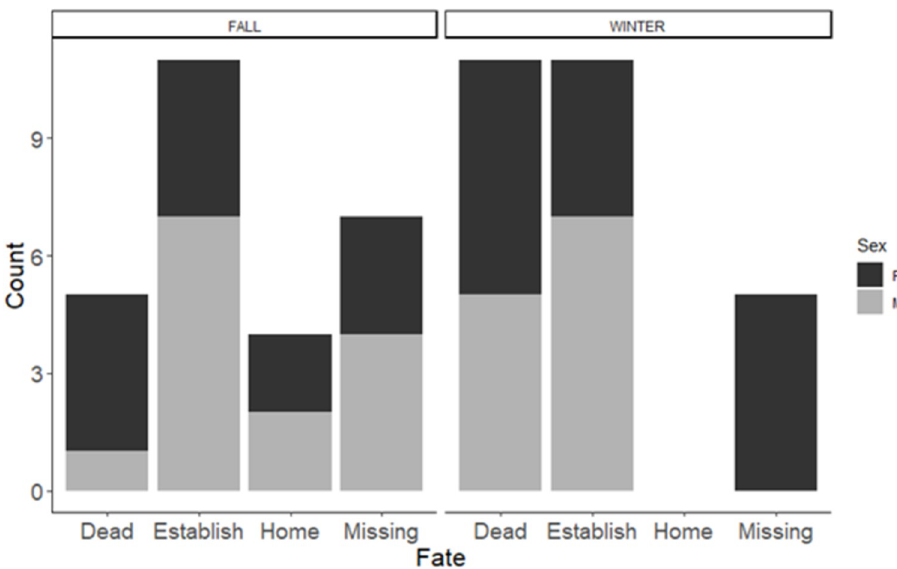
Fig 1. Number of red squirrels Tamiasciurus fremonti fremonti per different fate by sex and season (winter and fall), after translocation. The different fate has been identified as dead, establish (settled in a new area, different from the original home range), missing (when the animals was not trackable by telemetry and not possible to locate again), home (animals able to homing after being translocated).